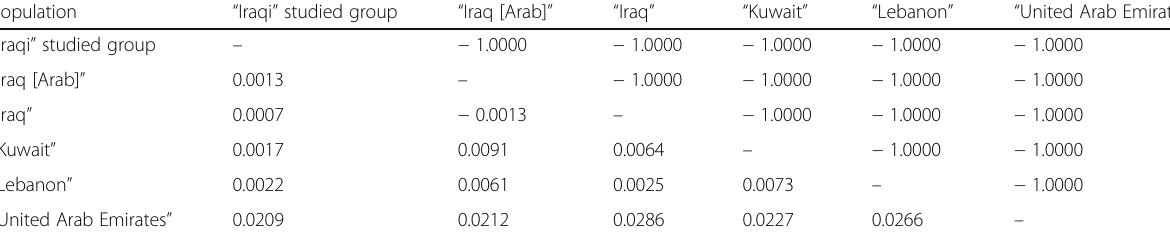
Table 5 Rst values for Iraqi and neighboring populations